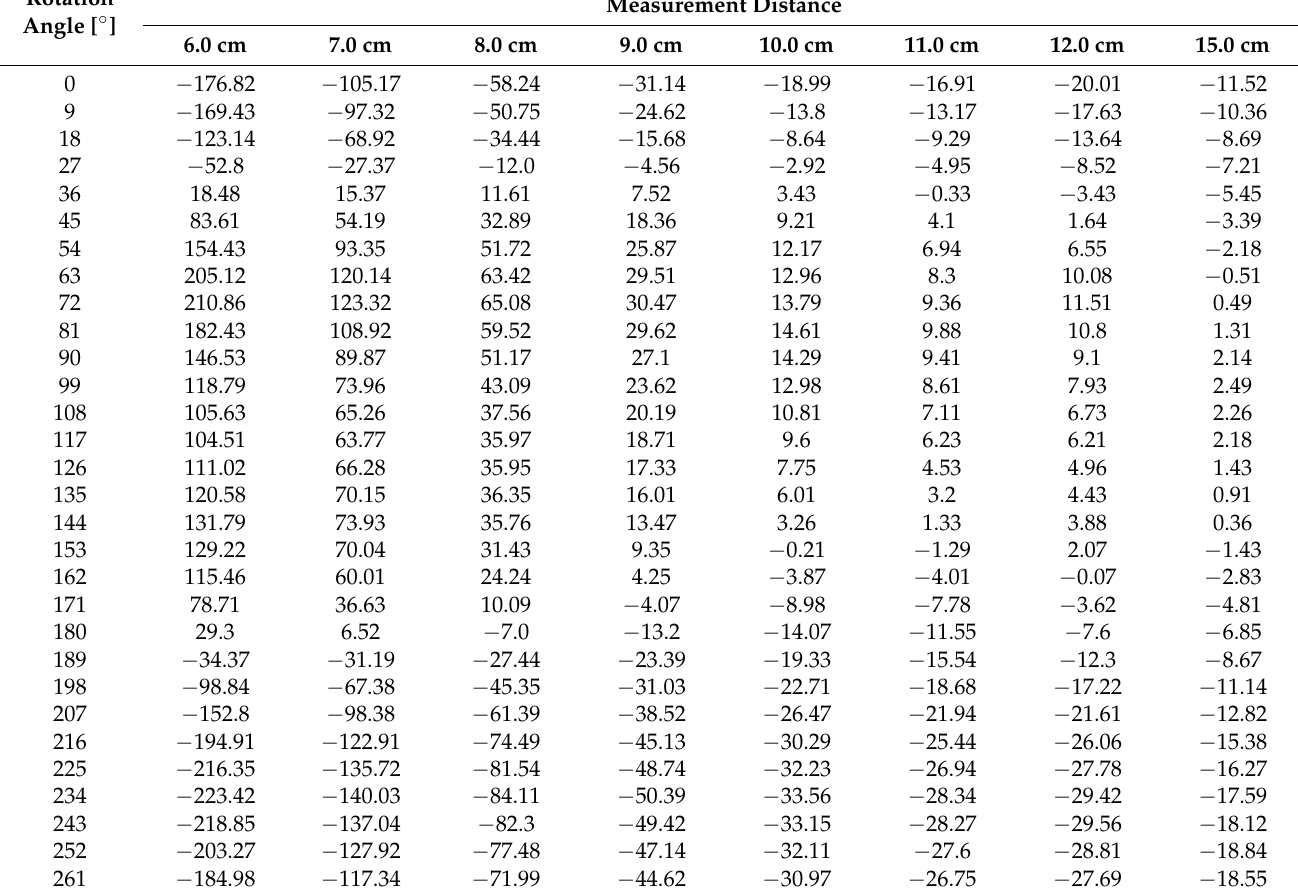
Figure 26. The three-dimensional view of the estimated value of the component B z ( left ) and total value B ( right ) of the magnetic induction of the examined magnets determined on the basis of the measurements. Table 7. Estimated values of the B x component of magnetic induction as a function of rotation angle and measurement distance.